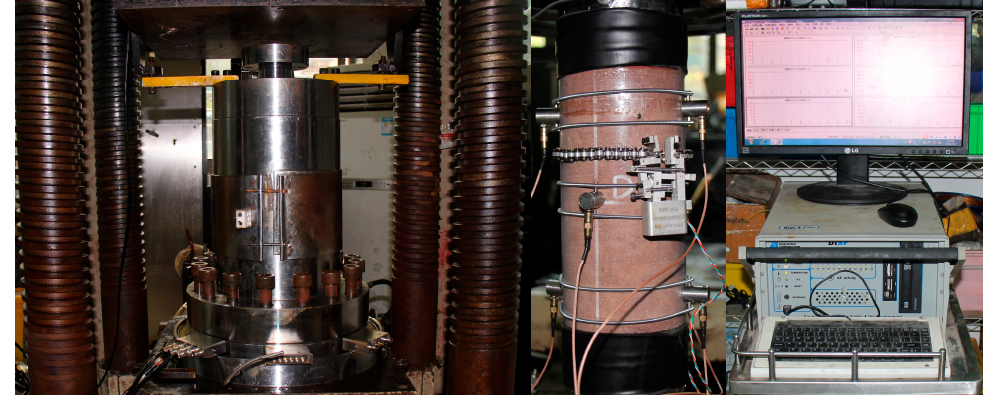
Figure 3. XTR01-01 micro-computer-controlled electro-hydraulic servo rock triaxial tester.